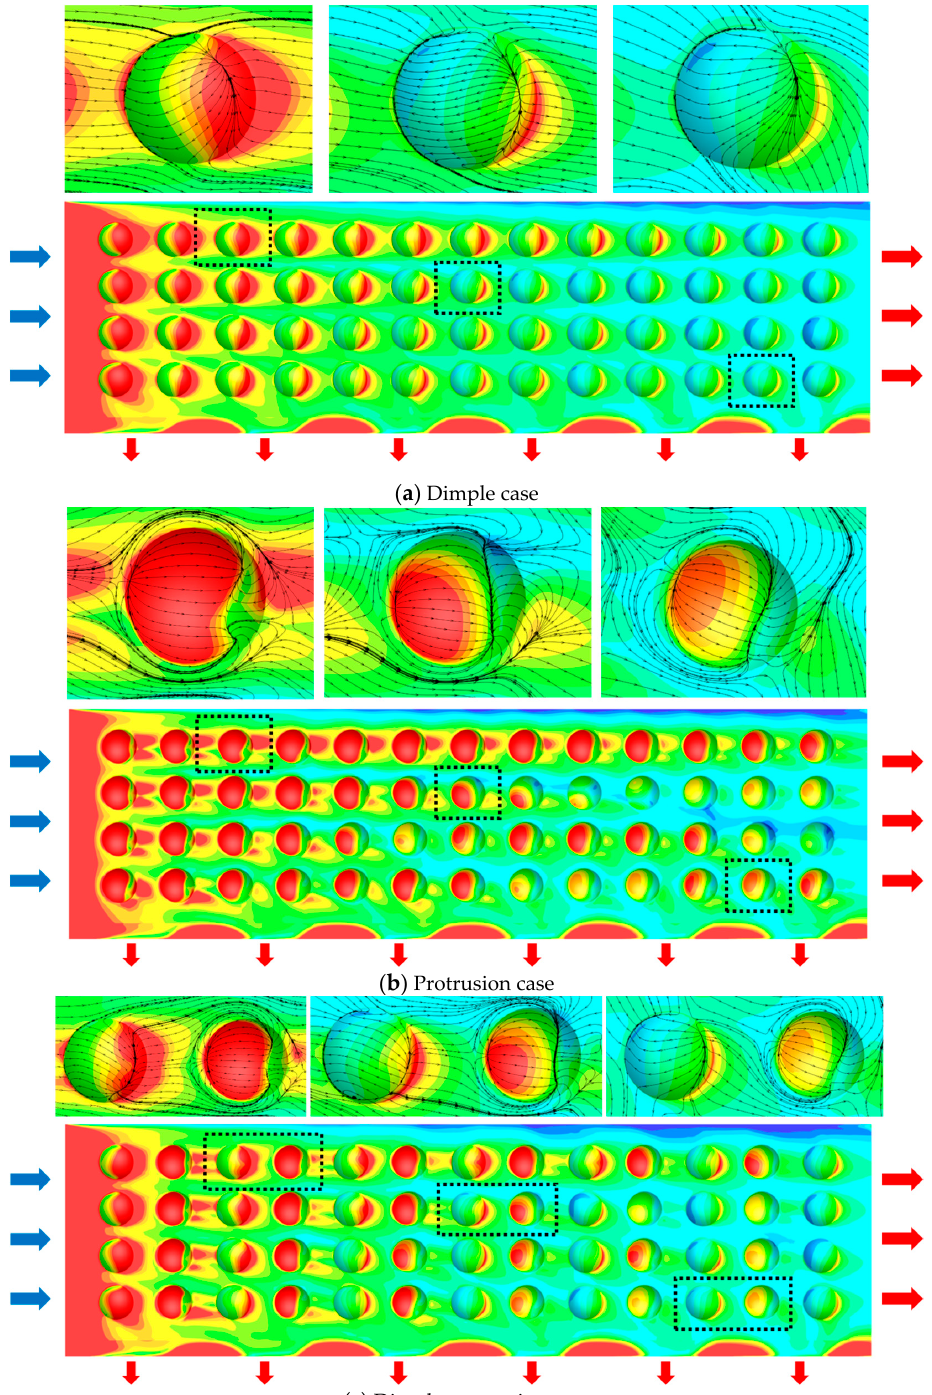
Figure 10. Nusselt number distributions and local limiting streamlines on the endwalls for different dimple/protrusion arrangements, Re = 30,000.